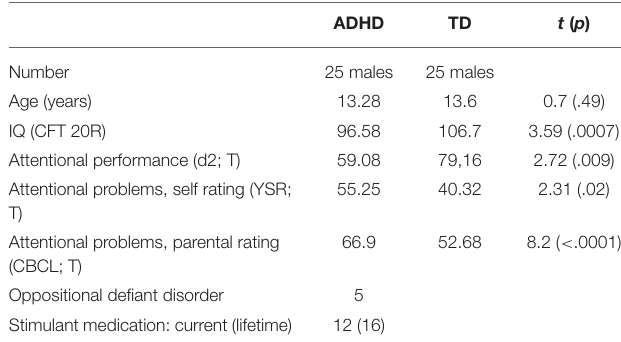
TABLE 1 | Description and group comparison of ADHD and typically developing (TD)